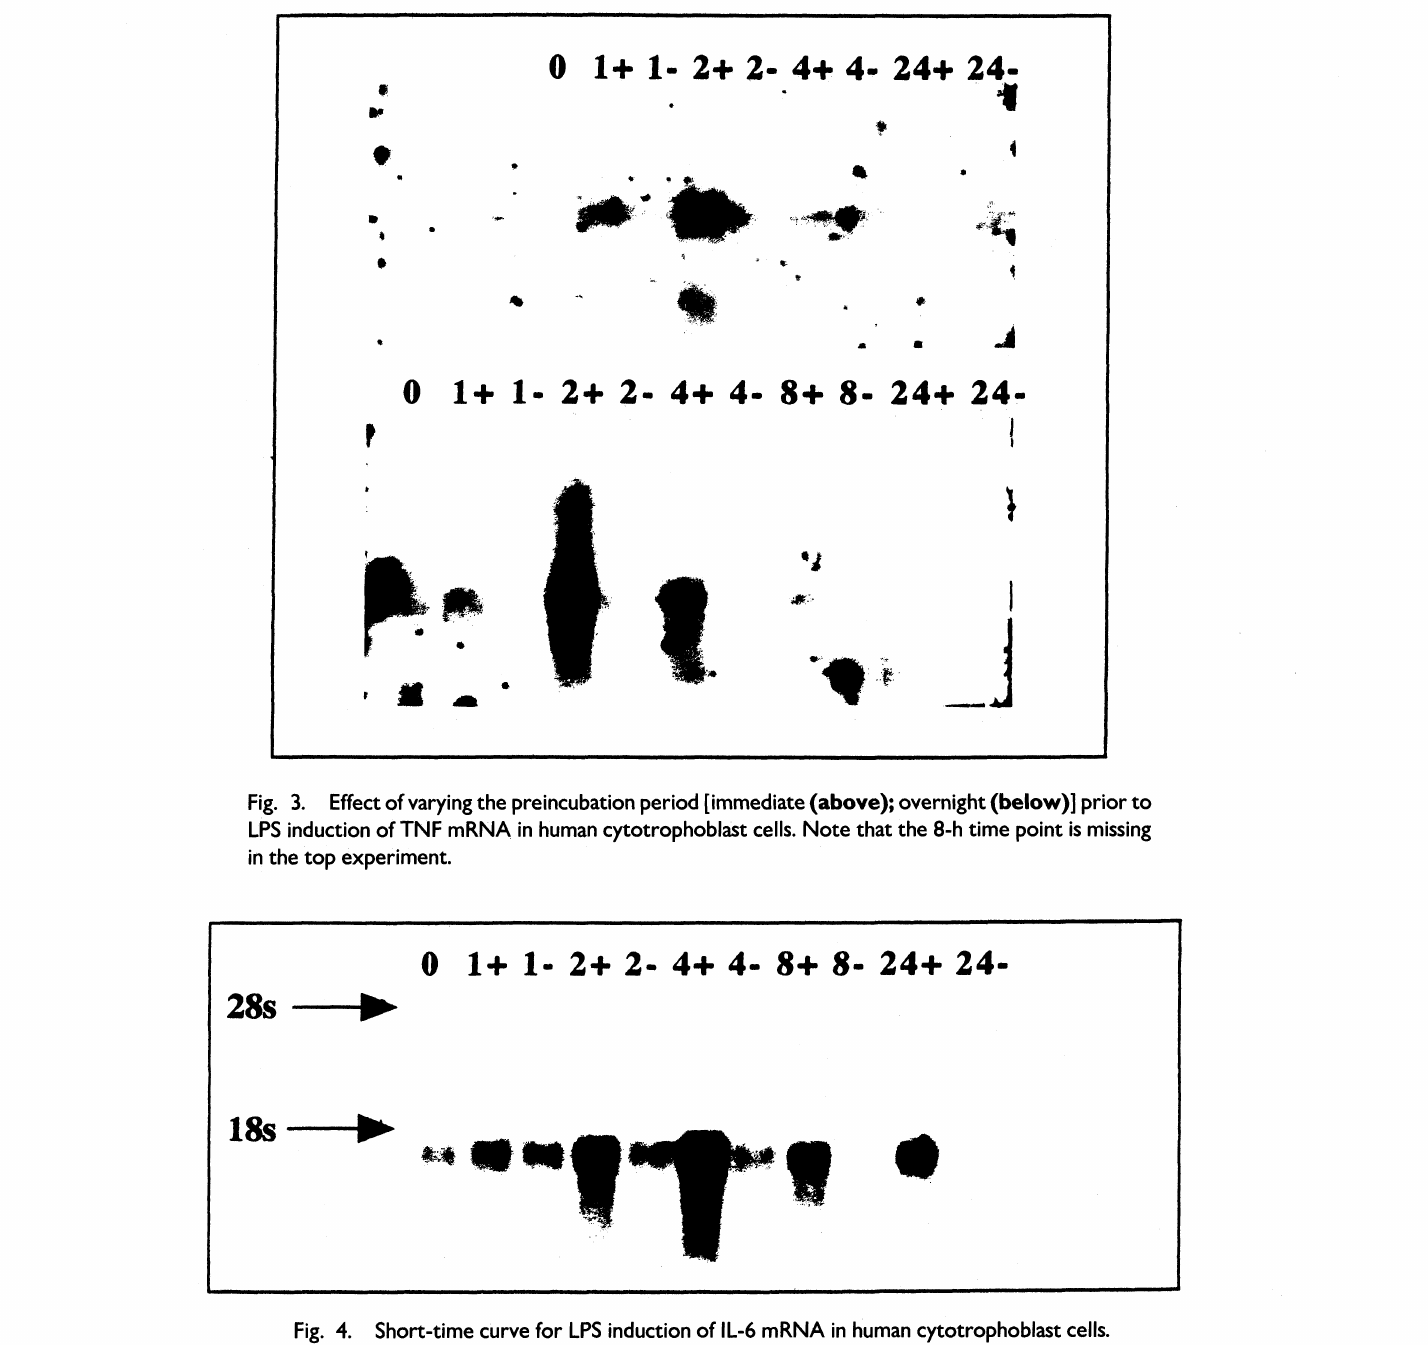
Fig. 3. Effect of varying the preincubation period [immediate (above); overnight (below)] prior to LPS induction of TNF mRNA in human cytotrophoblast cells. Note that the 8-h time point is missing in the top